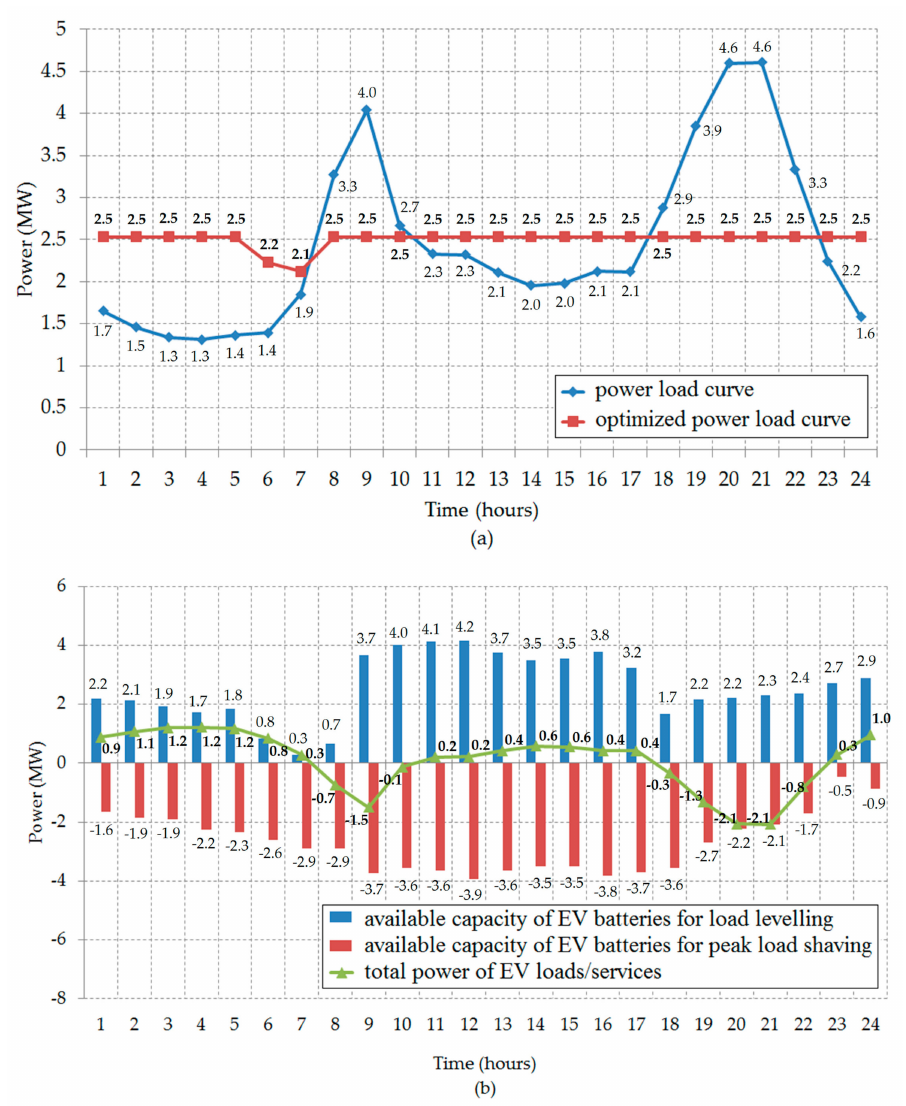
Figure 11. Detailed description of the best optimized scenario: ( a ) optimized power load curve ( b ) optimized EV charging and discharging power within constraint